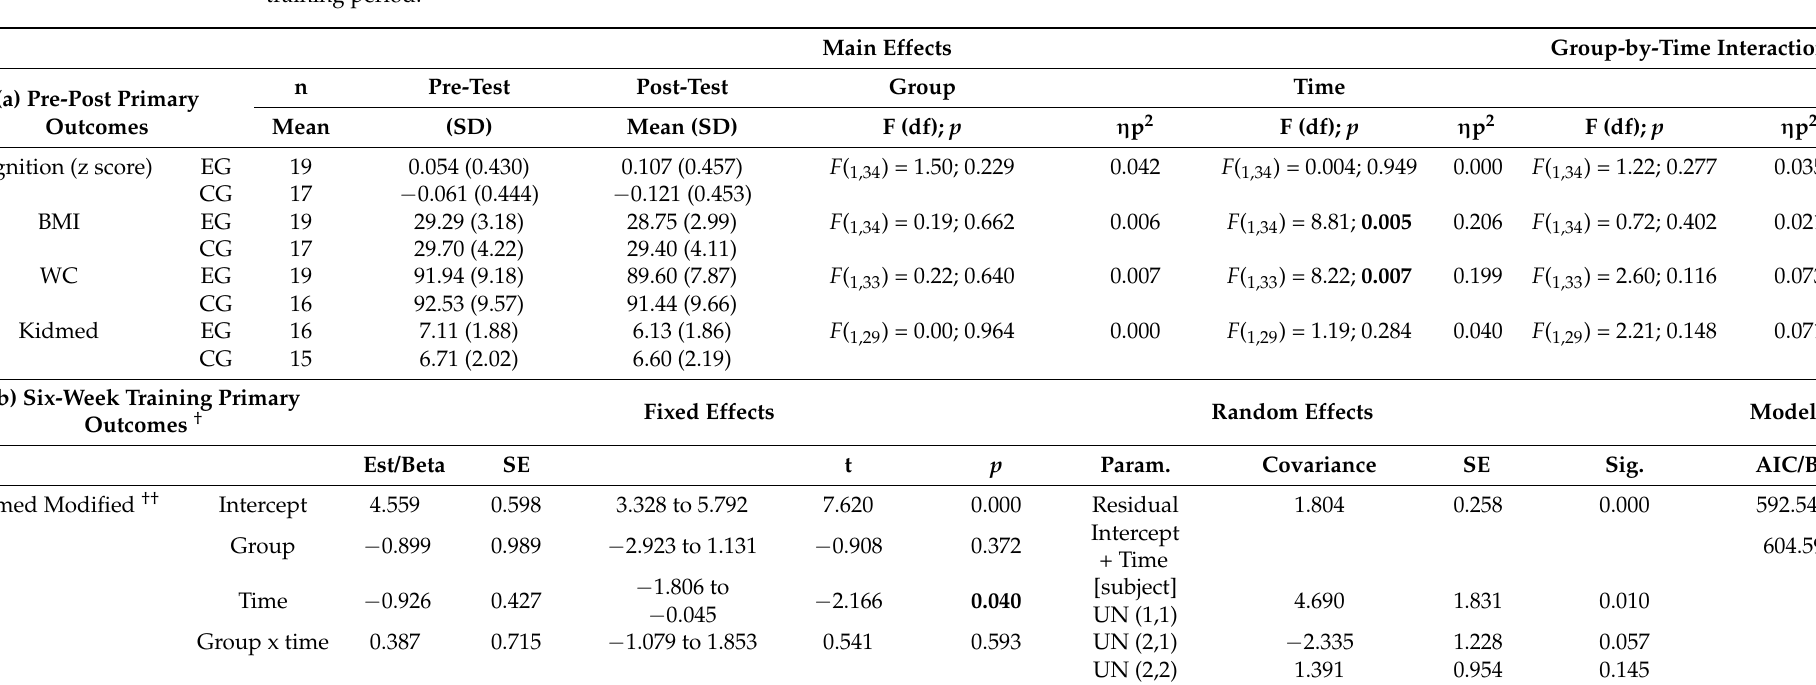
Table 2. EF training effects on primary outcomes: (a) cognition and anthropometric pre-post measures and (b) evolution of food choice across the 6-week training